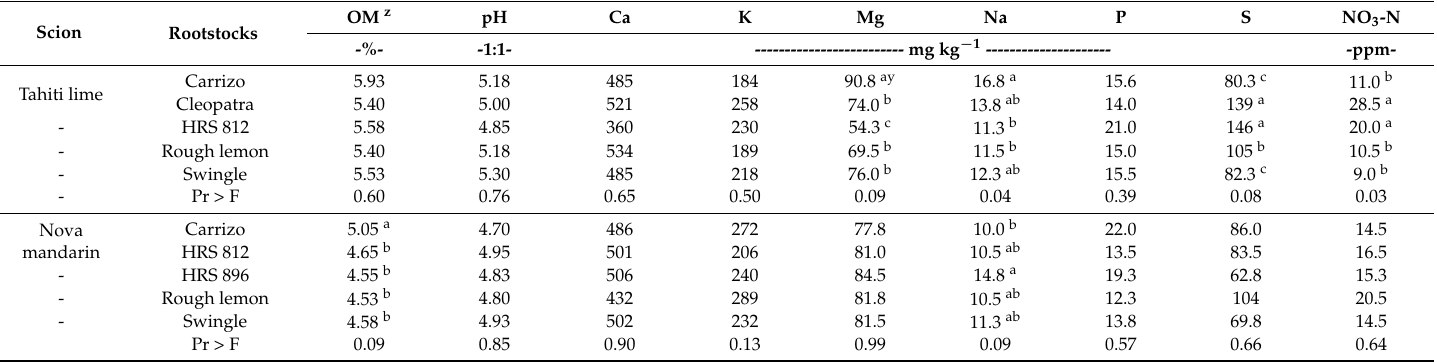
Table 1. Soil nutrients in two citrus orchards grown in Coto series grafted in five different rootstocks in the Agricultural Experiment Substation of Isabela, Puerto Rico. Scion